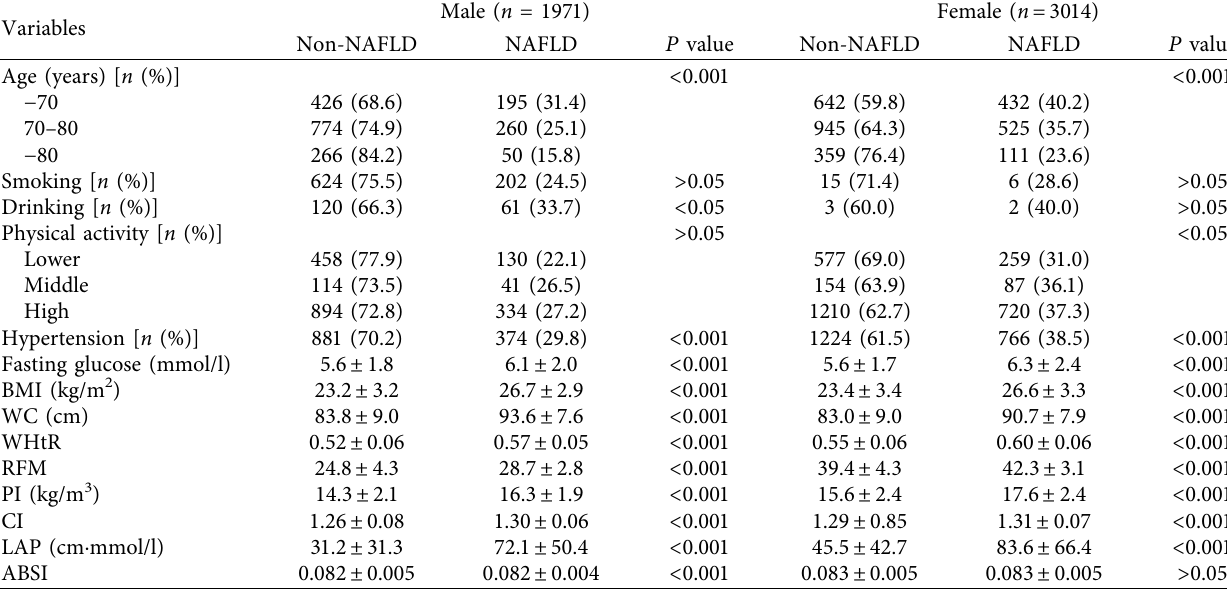
Table 1: Characteristics of subjects with NAFLD stratified by